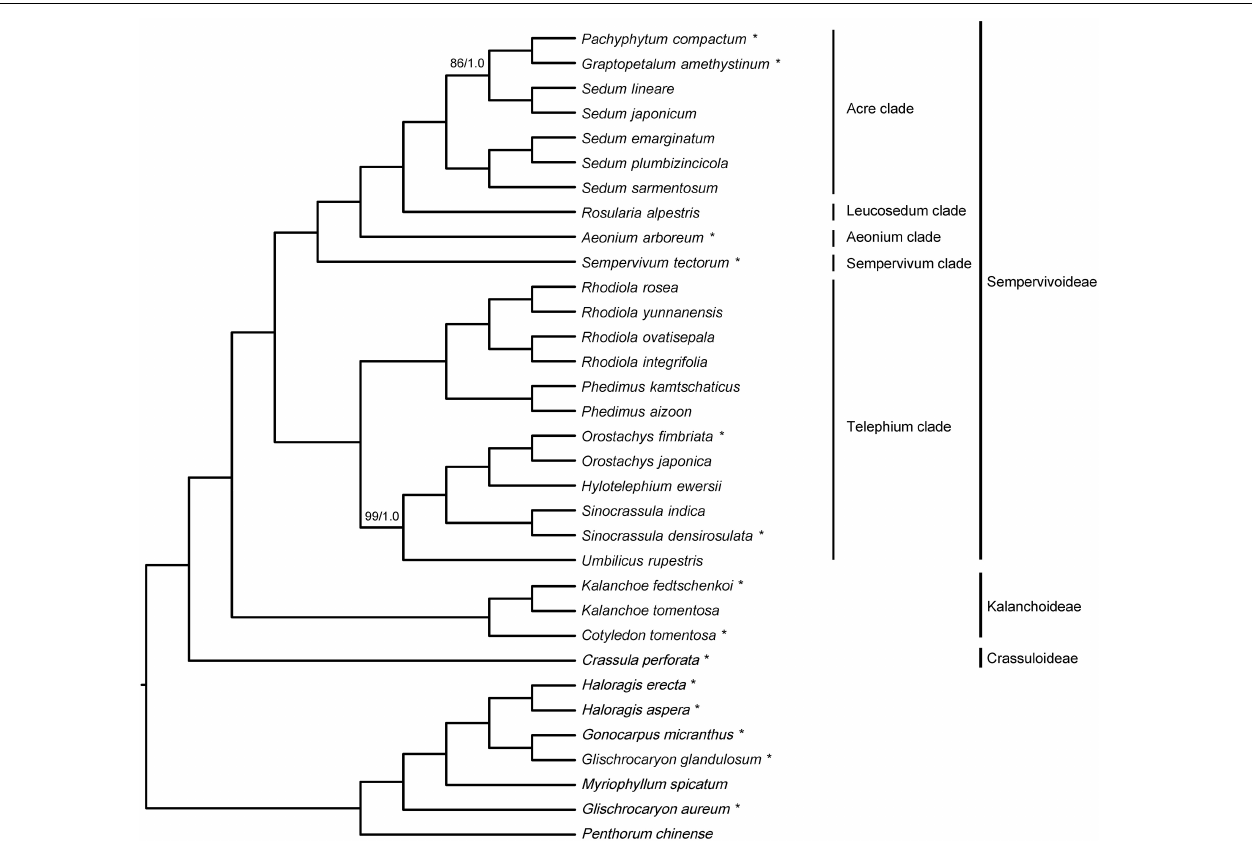
FIGURE 3 | Phylogenetic inference of 33-taxon supermatrix using maximum likelihood (ML) and Bayesian inference (BI) methods. Branch support was assessed using ML bootstrap percentage (BP) and Bayesian posterior probability (PP), and internal branches with less than 100 BP/1.0 PP are indicated with corresponding values. Species with newly sequenced chloroplast genomes are marked with the asterisks, and clade designations are labeled